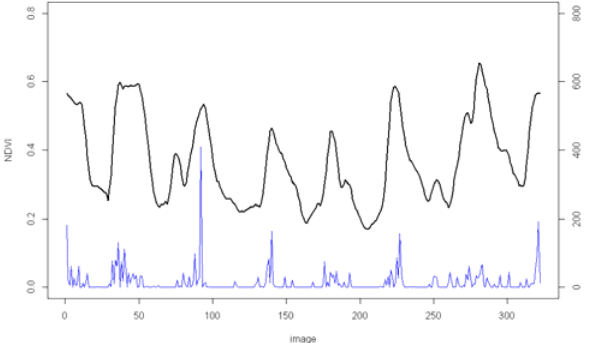
Figure 3: Time series of rainfall (blue line) and NDVI (black line) for a location in an open woodland.